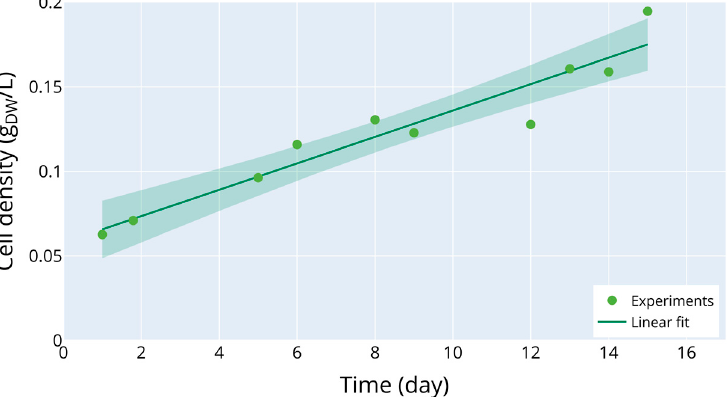
Figure 2. Biomass density over the first part of the run (from 50 mL samples) and its linear fit. Culture medium volume: 52 L. Fitted values: density (g DW /L) = 7.81 × 10 − 3 × time (day) ± 57.8 × 10 − 3 . R 2 = 0.914.